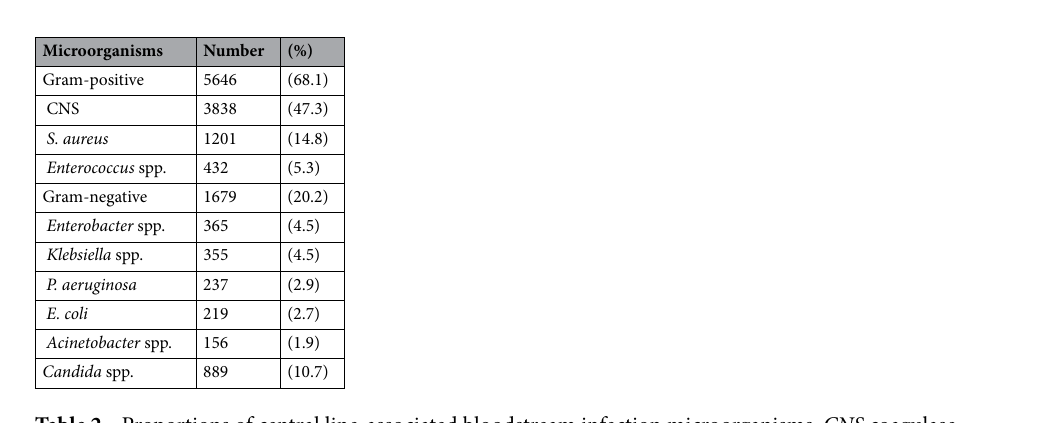
Table 2. Proportions of central line-associated bloodstream infection microorganisms. CNS coagulase- negative staphylococci.